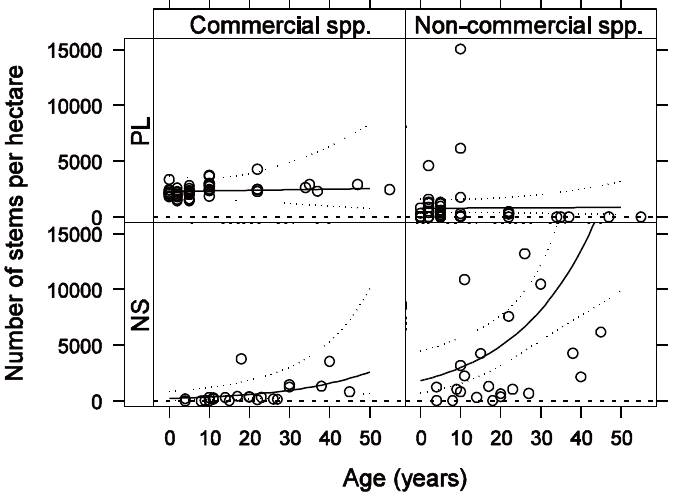
Figure 3. Stem abundance of commercial and non-commercial plant species for plantation (PL) and natural succession (NS) established on fallow lands. Dashed lines represent limits of the 95% confidence